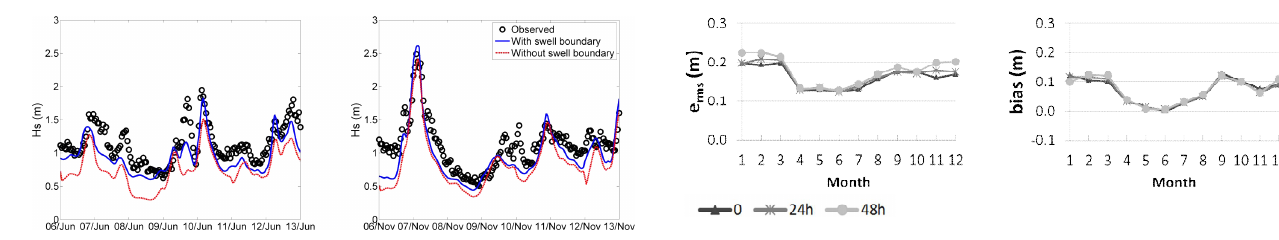
Figure 11. Significant wave height H s for Eierlandse Gat for the month of June (left) and November (right): black – observed; blue – with swell boundary; red – without swell boundary.